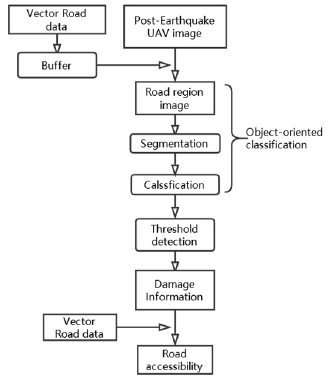
Figure 1. Flowchart of this